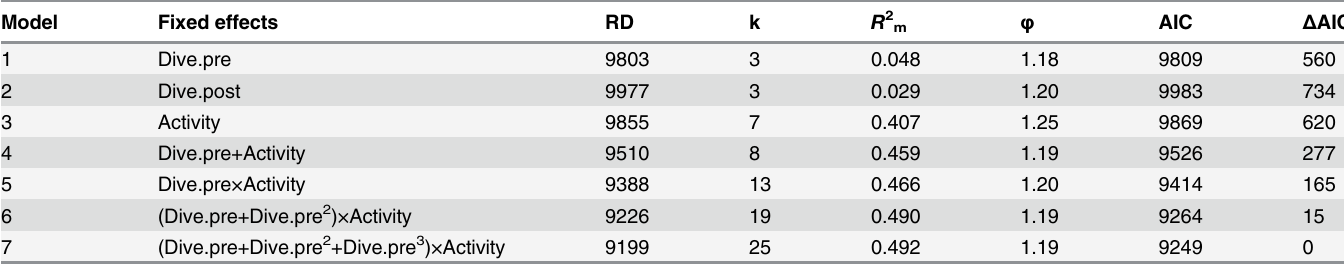
Table 4. Model selection results of the GLMM to explain the number of short dives in a surfacing bout for minke whales.